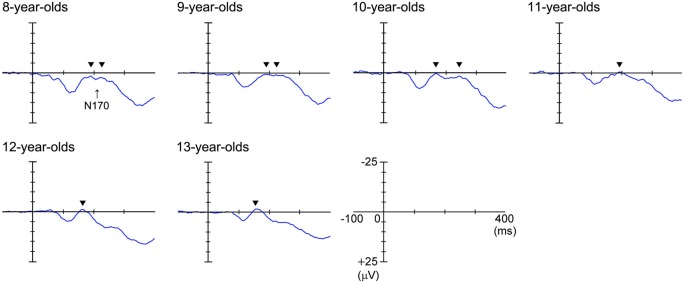
Grand-averaged waveforms recorded at the T6 (right) electrode in response to the upright face stimuli. N170 was a large negative deflection between 150–250 ms for all ages in this figure. The large negative deflection (N170) was longer in duration and/or had at least two peaks in the 8–11-year-old children, whereas it was sharp and had one peak in the 12–13-year-old children. The black arrows indicate the abovementioned peaks.